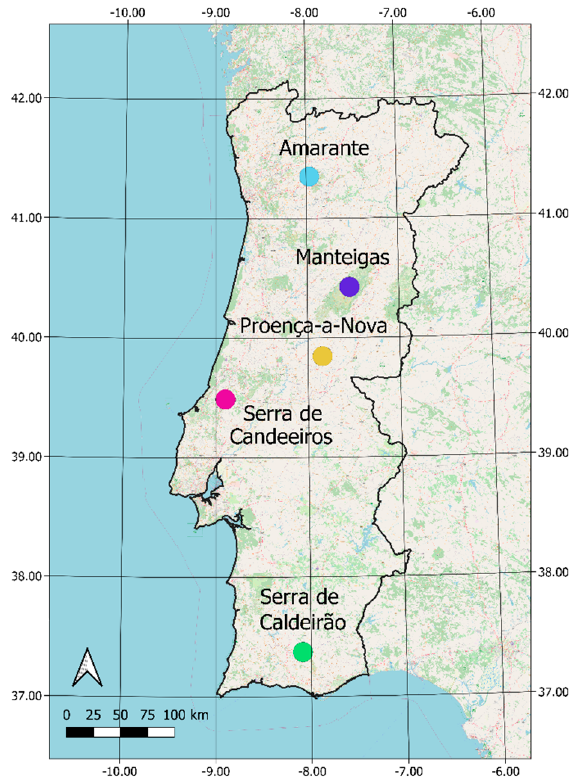
Figure 2. Locations of the five study areas in Portugal. Table 2. Study sites studied years, fuel break area, land cover composition and climate conditions.